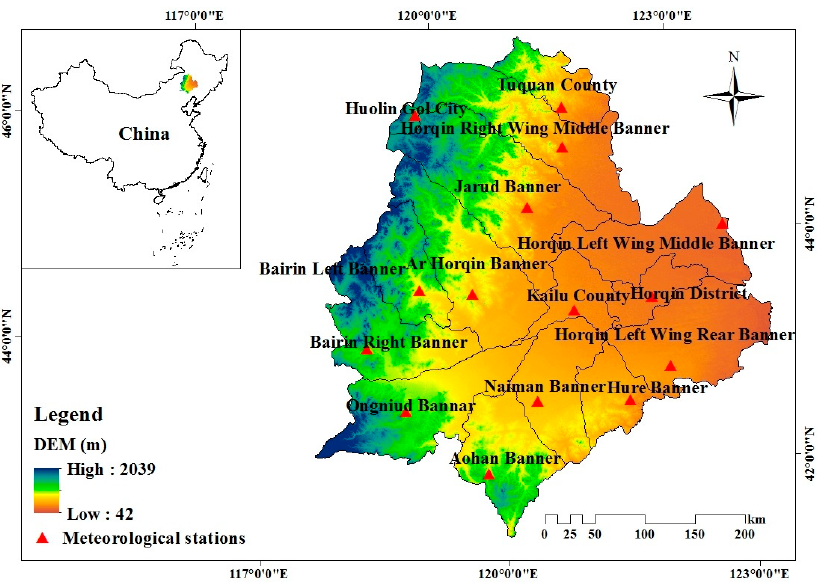
Figure 1. Horqin Sandy Land, Location, and the meteorological stations.